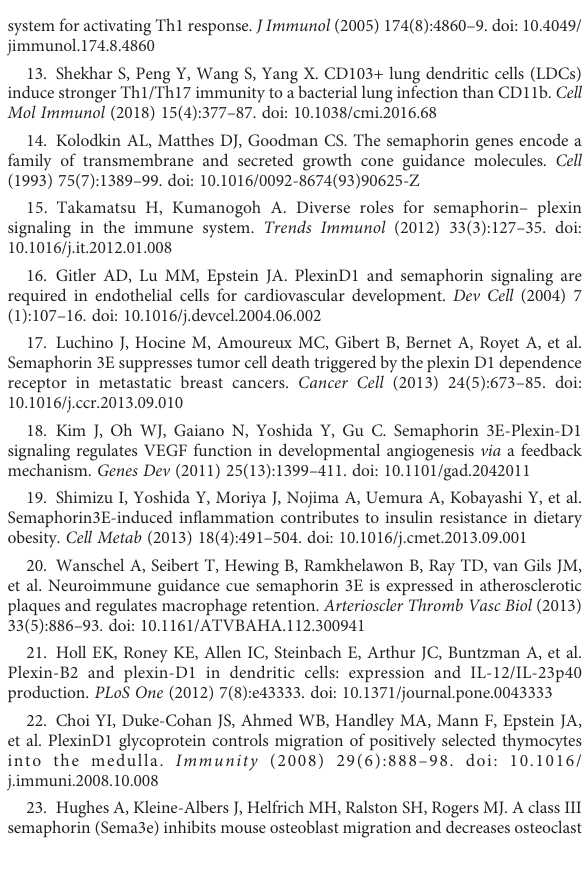
SUPPLEMENTARY FIGURE 1 (A) Exogenous recombinantSema3E-Fc wasadministered tomicegroups intranasally 2 hours before Cm infection and day 1 to day 6 after infection. (B) Gating strategy of lung DC. Lung DCs were identi fi ed according to CD11c hi MHC-II hi F4/80 - expression. (C) Gating strategy of lung T cells. Lymphocytes were identi fi ed based on surface expression of CD3 and further gated on CD4 and